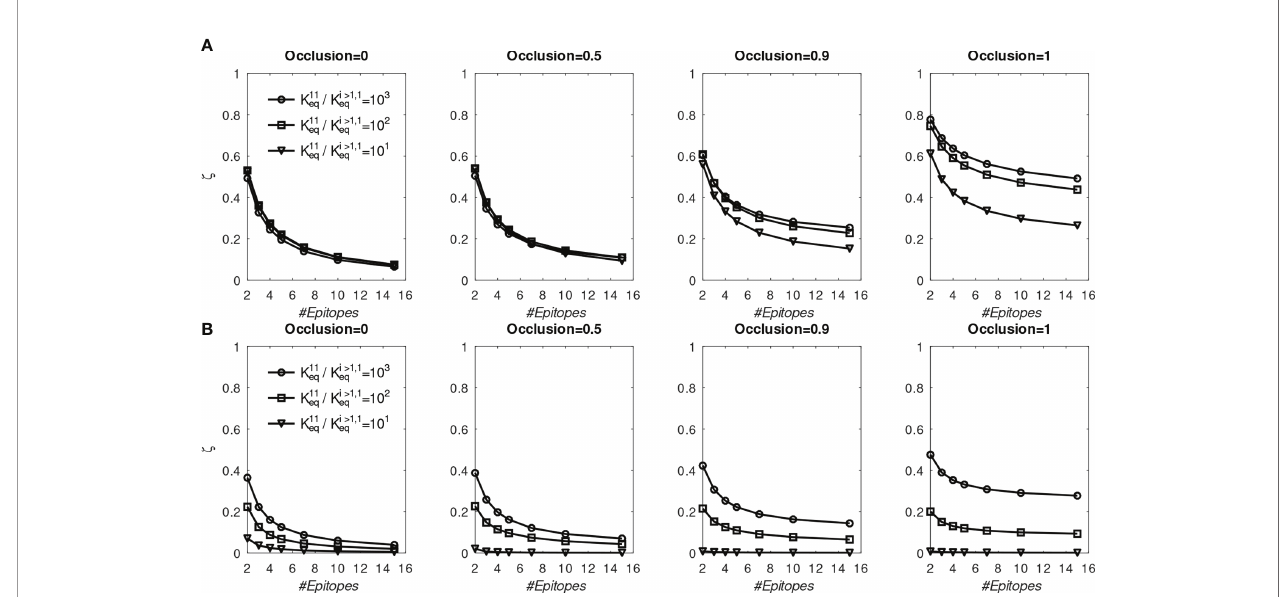
FIGURE 6 | Fraction of MBC#1 ( z , de fi ned in the text) at the end of six GC simulations for different initial af fi nity advantage values vs. total number of BCR/Epitope pairs. (A) BCR#1 is cooperatively bivalent (K 12 eq =10K 11 eq ); (B) BCR#1 is monovalent (K 12 eq